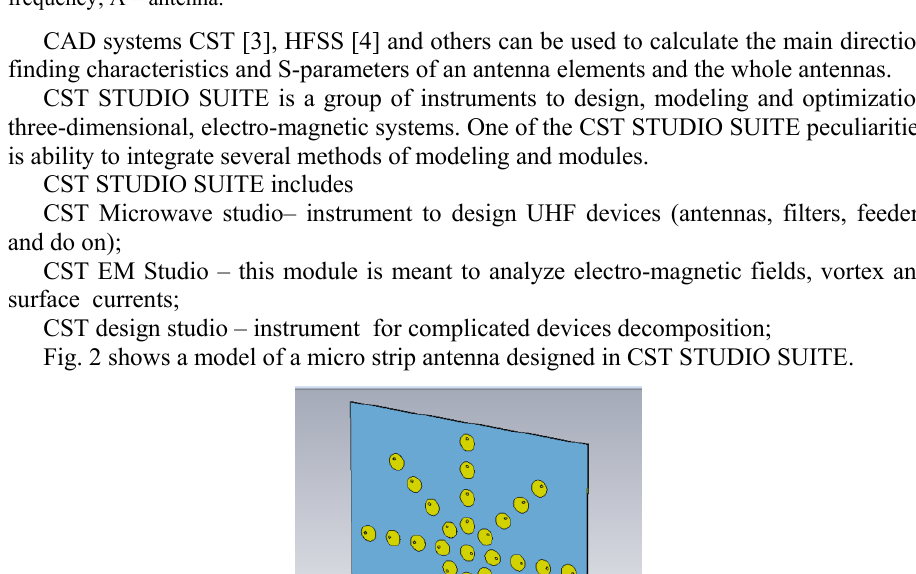
Fig. 1. The functional circuit an active DPA with the frequency transformation. Sw – microwave oven switch; LNA – low noise amplifier; FC – frequency converter; ADC – analog-digital converter; DAC – digital-analog converter; DR – digital receiver; GS – generator of signals; AHF – amplifier of high frequency; A – antenna.